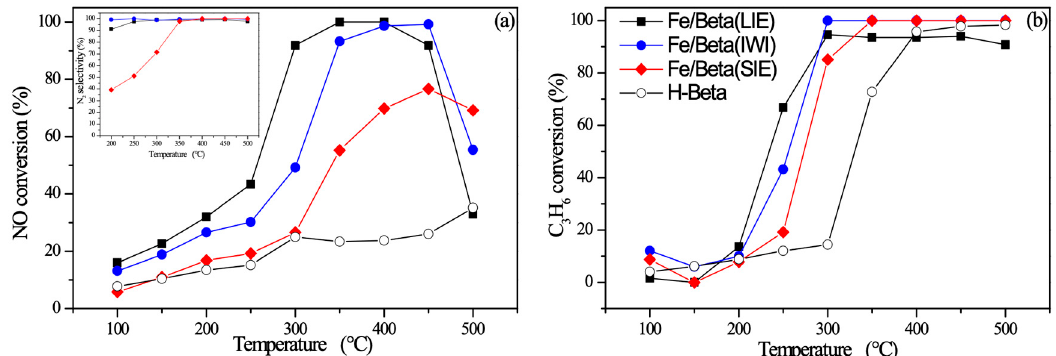
Figure 7. NO conversion and N 2 selectivity ( a ) and C 3 H 6 conversion ( b ) over pure H-beta and Fe/Beta catalysts prepared by different methods. The inlet gas mixture consisting of 0.05% NO, 0.05% C 3 H 6 ,